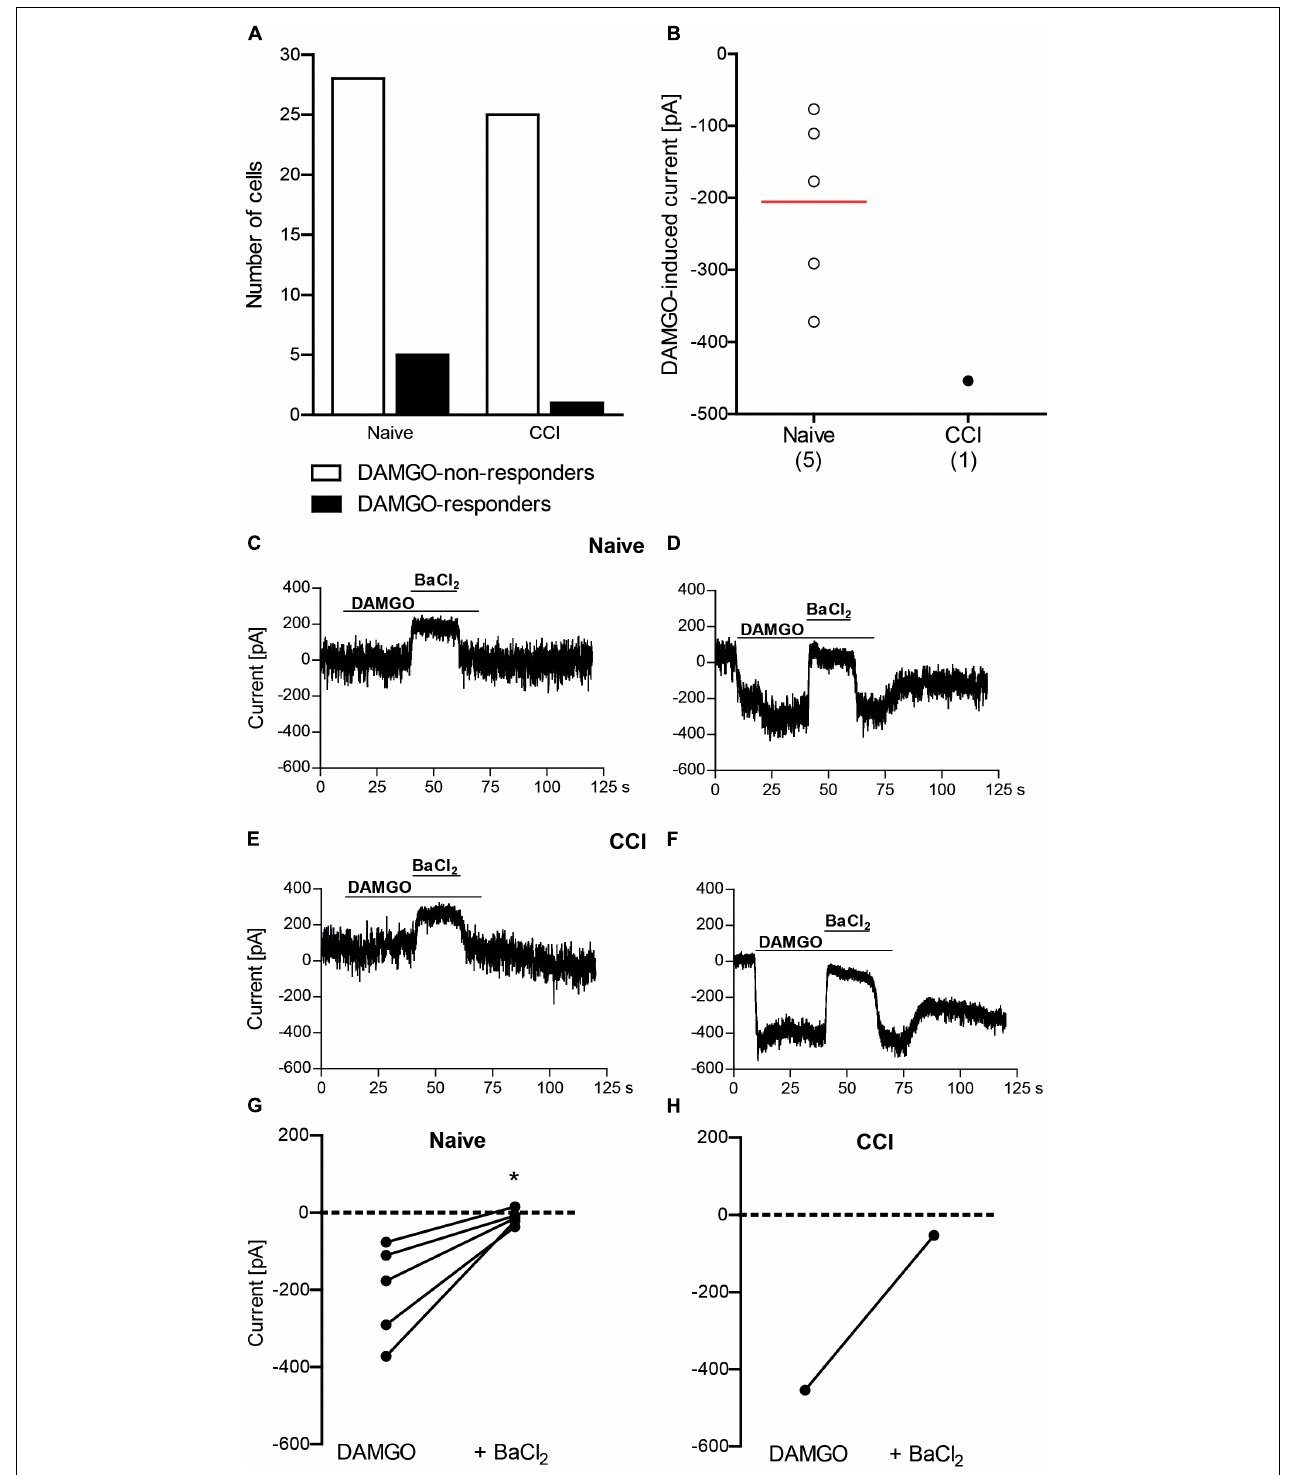
FIGURE 2 | DAMGO (10 µ M) induces potassium currents in mouse DRG neurons, assessed in the voltage clamp mode. (A) Number of neurons responding and non-responding to DAMGO from naïve and CCI mice. The proportion of DAMGO-responding to DAMGO-non-responding neurons from naïve vs. CCI mice did not differ significantly ( P = 0.2148; Fisher’s exact t -test). The neurons were sampled from cultures obtained from DRG of nine naïve mice and eight CCI mice. (B) Single neuron currents in DAMGO-responders. The data points represent single neuron values, and the red horizontal line indicates the mean. Numbers in brackets